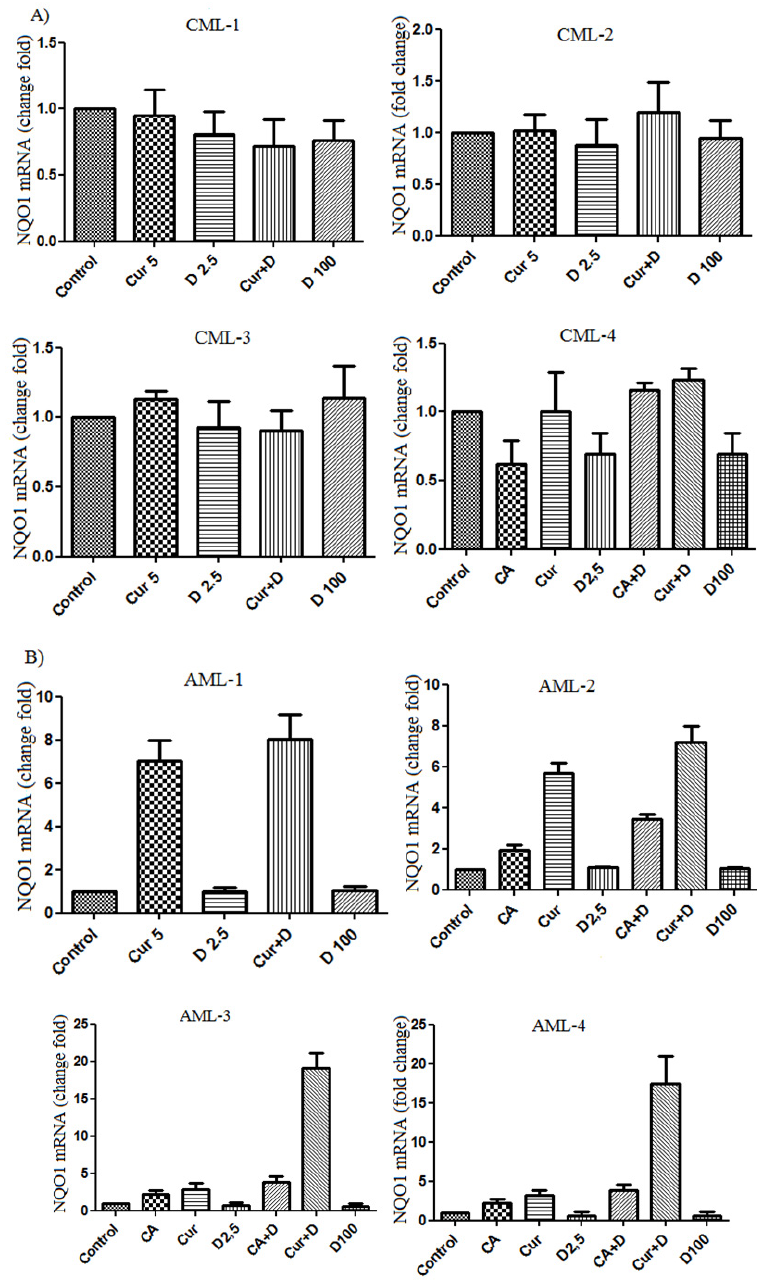
Fig. 2. NQO1 mRNA expression level in CML (A) and AML (B) patients leukemic cells treated with CA (10 µÀM), 1,25D (2.5 nM) and 1,25D (100 nM), CUR (5 µÀM) and combinations of 1,25D (2.5 nM) with CA and CUR. Data are the means ±